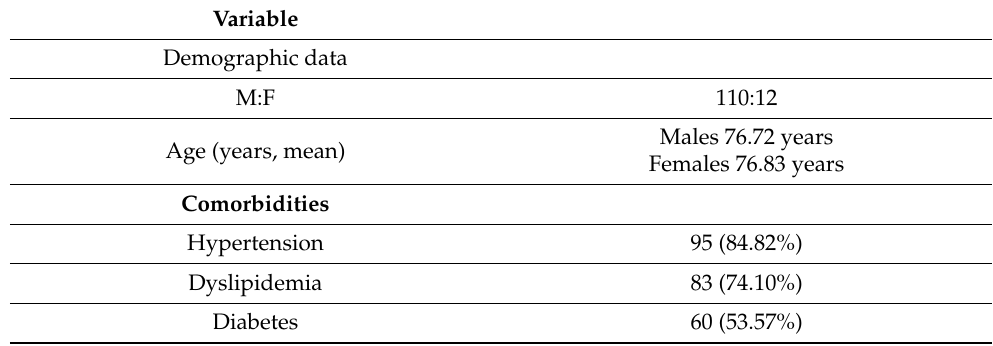
Table 1. Patients’ characteristics: demographics and comorbidities of the entire cohort ( n =